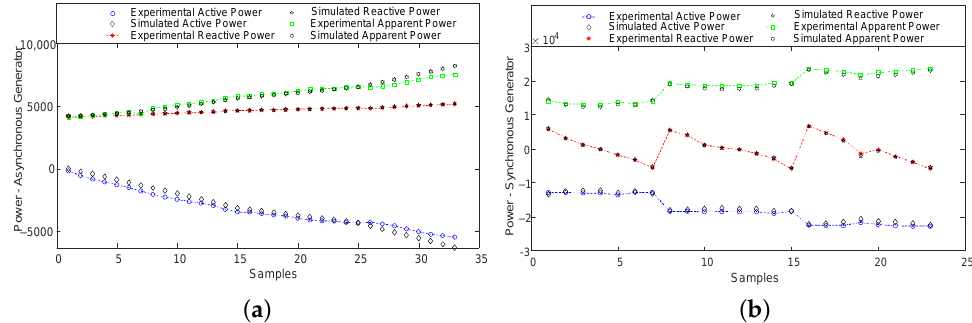
Figure 8. Comparison between simulated and experimental: ( a ) induction generator and ( b ) syn- chronous generator.